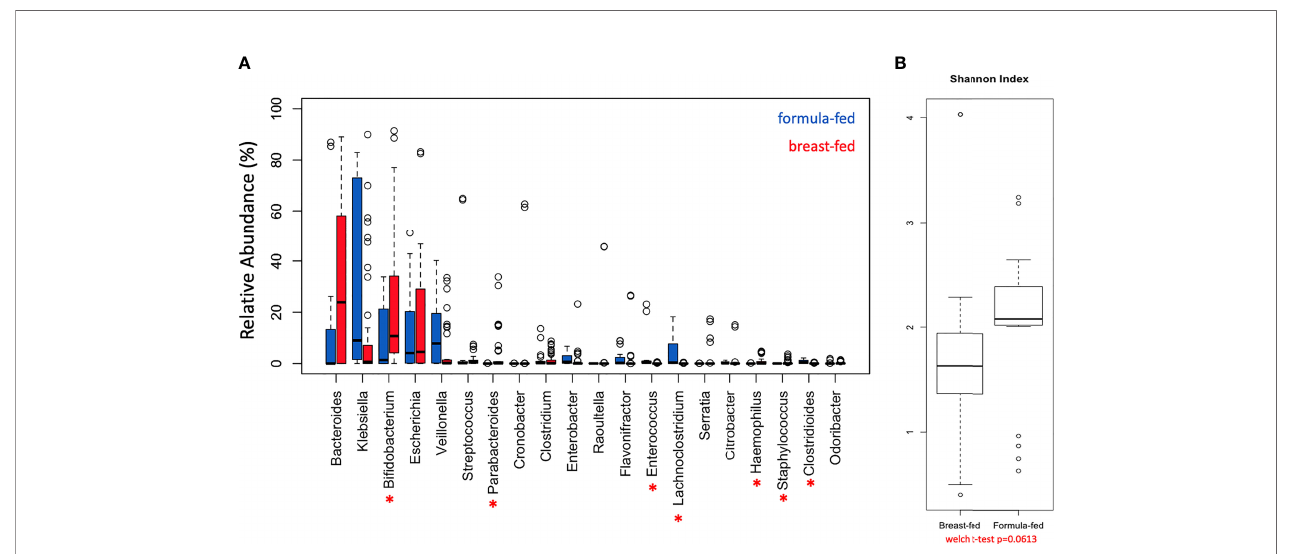
FIGURE 1 | Differentially Represented Genera. Distribution of genera identi fi ed in the gut microbiome of breast-fed and formula-fed infants. (A) Boxplot of the topmost abundant genera in breast-fed infants (red boxes) and the topmost abundant genera in formula-fed infants (blue boxes). The red asterisks represent the genera that were statistically different between the breast-fed and formula-fed cohorts. The y-axis represents phylogenetic abundance (percentage), and each genus is represented on the x-axis. Asterisk (*) represents some of the 39 genera in total that were differentially represented with FDR ≤ 0.01. (B) Shannon diversity index comparing breast-fed and formula-fed